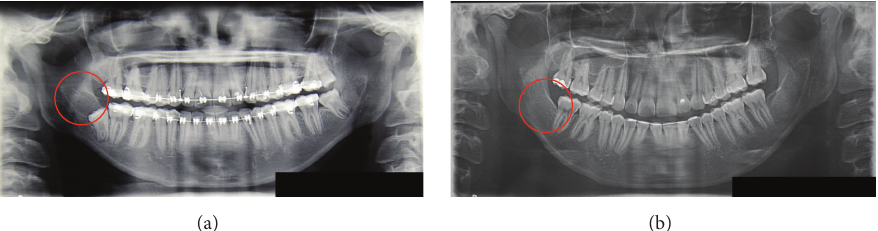
Figure 1: Panoramic radiograph before and after treatment. (a) Panoramic radiograph showed that the presence of a unilocular radiolucent lesion was shown in the right mandibular ramus, involving the impacted tooth 48. (b) The patient was followed up and, 12 months later, no sign of recurrence was detected.